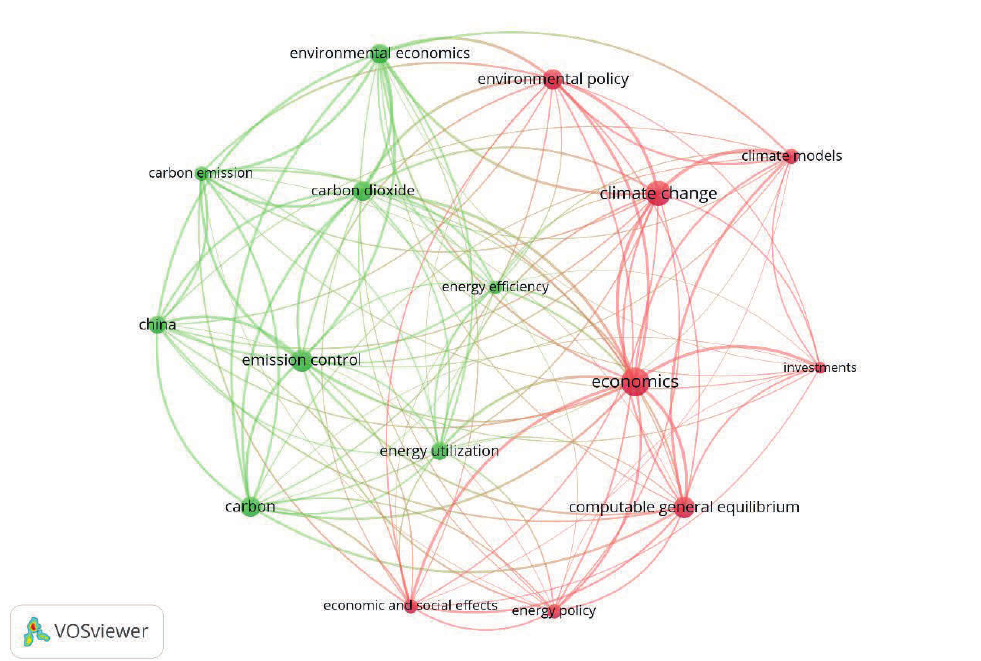
Fig. 7. Keyword co-occurrence for 3 rd query with a threshold of at least 10